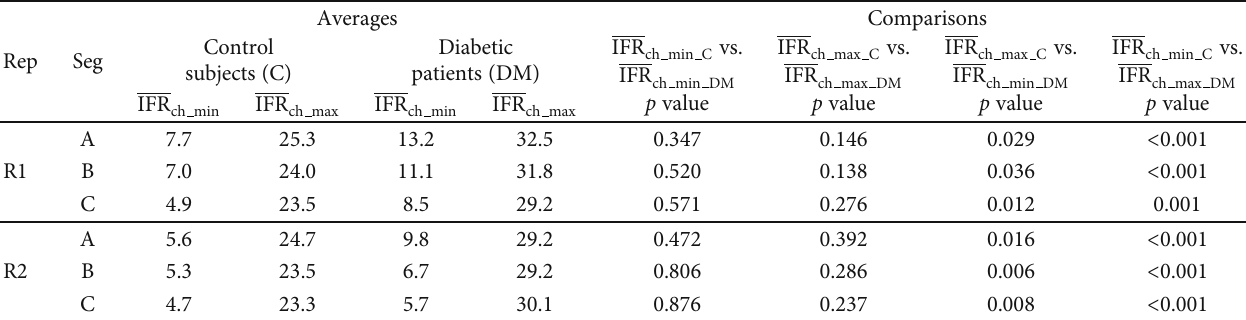
Table 1: Comparison of average invisible facial redness ( IFR at the least reddish check of each subject and IFR Seg =segment of the